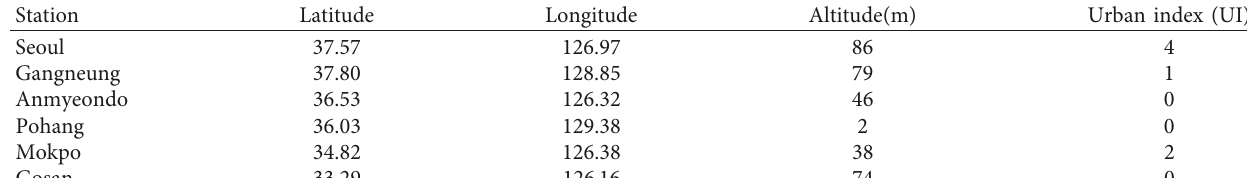
Table 1: List of representative region for the UV